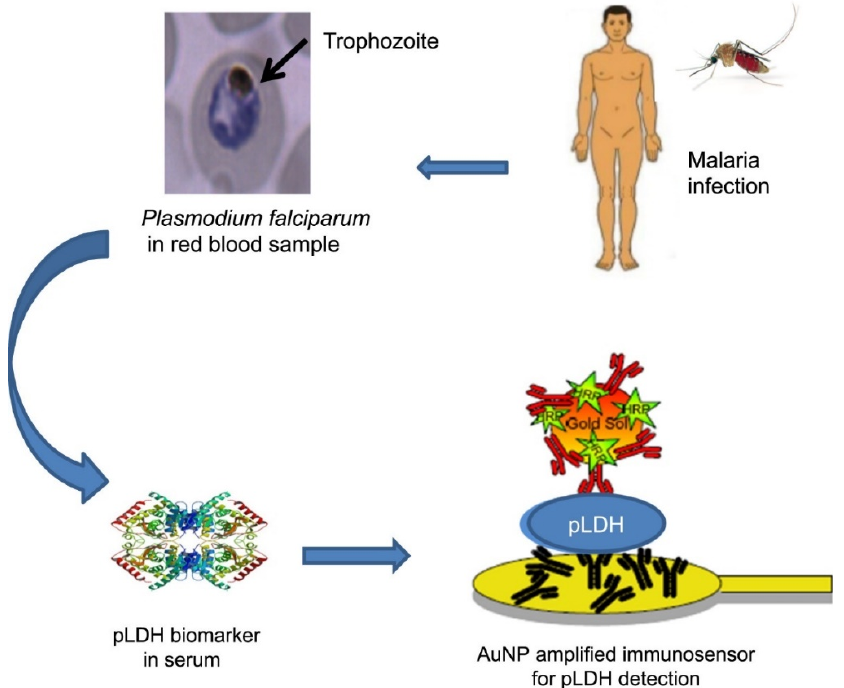
Figure 5. Schematic diagram of the process of LDH detection by immunosensor [115]. Copyright 2018